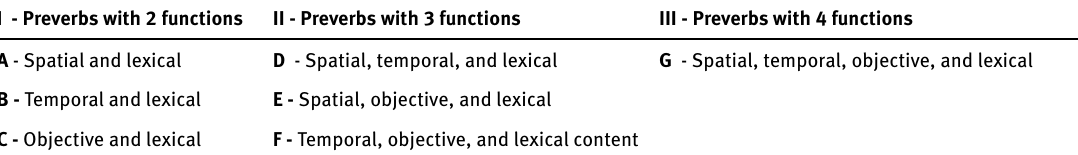
Table 2 . Language groups and subgroups with